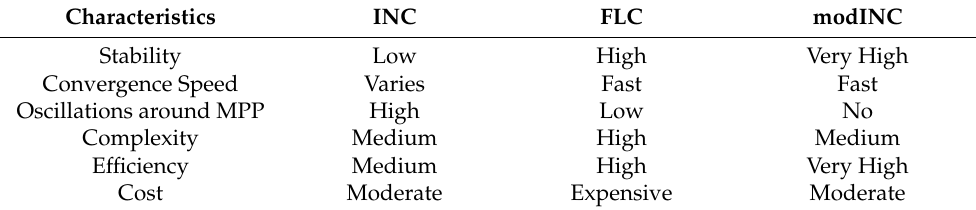
Table 3. Characteristics comparison of each MPPT algorithm studied.